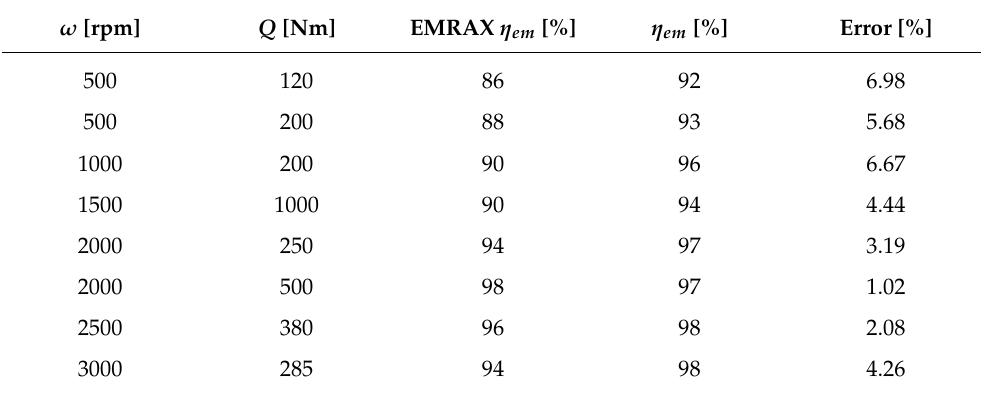
Table 2. Comparison of some points (rotational speed ω and torque Q ) of the efficiency maps from EMRAX manual [26] and the developed